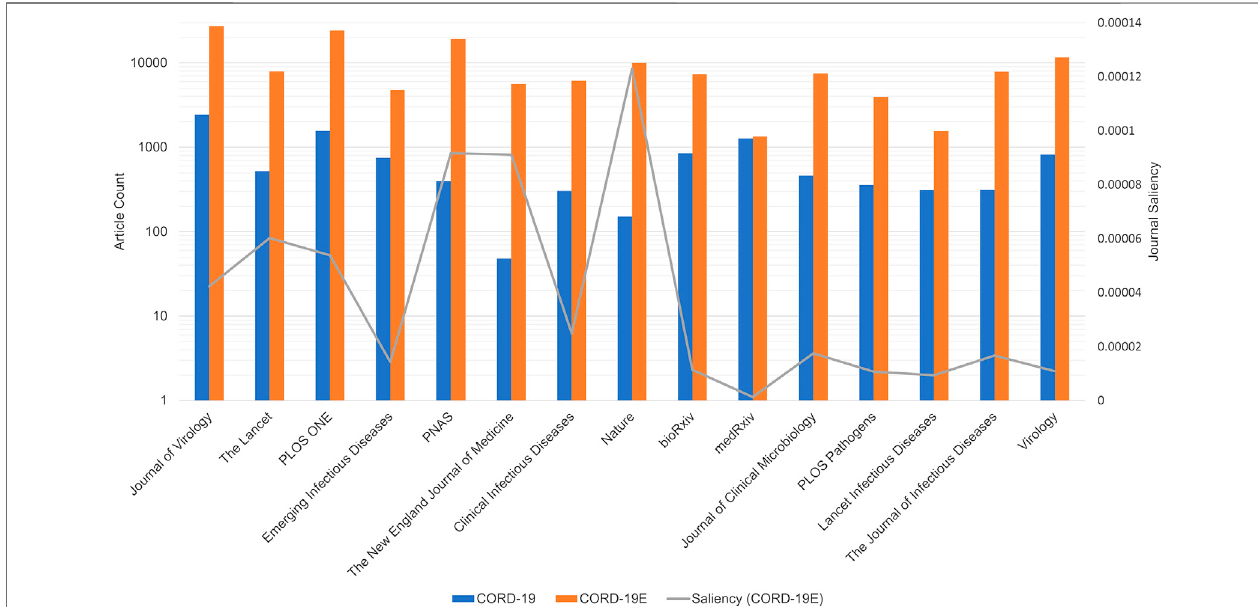
FIGURE 7 | Article counts (primary vertical axis in log scale) in COVID-19 Research Dataset (CORD-19) and CORD-19E from the top 15 journals ranked by salienciesbased onCORD-19articles.An unevencoverage amongjournals inCORD-19canbeseenagainst theCORD-19Ebaseline,withmedRxiv having thehighest coverage in almost all CORD-19E articles that are already included in CORD-19. Additionally, the journal saliencies computed from CORD-19E are overlaid as the gray line along the secondary vertical axis. The journal rankings derived from the two datasets show dramatic differences.